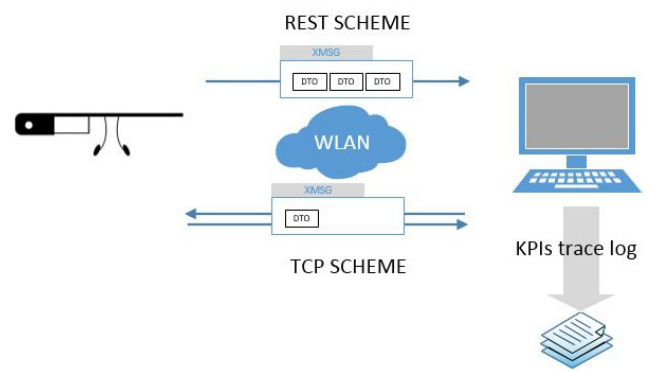
Figure 2. Communication schema used to perform the experiments by the implementation of TCP scheme (bottom) please define and REST (top)